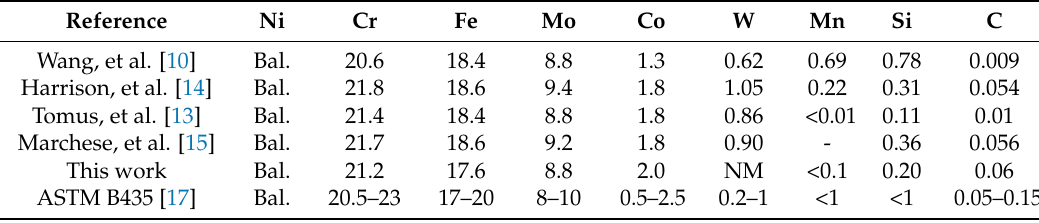
Table 1. Comparison of the composition of Hastelloy X from